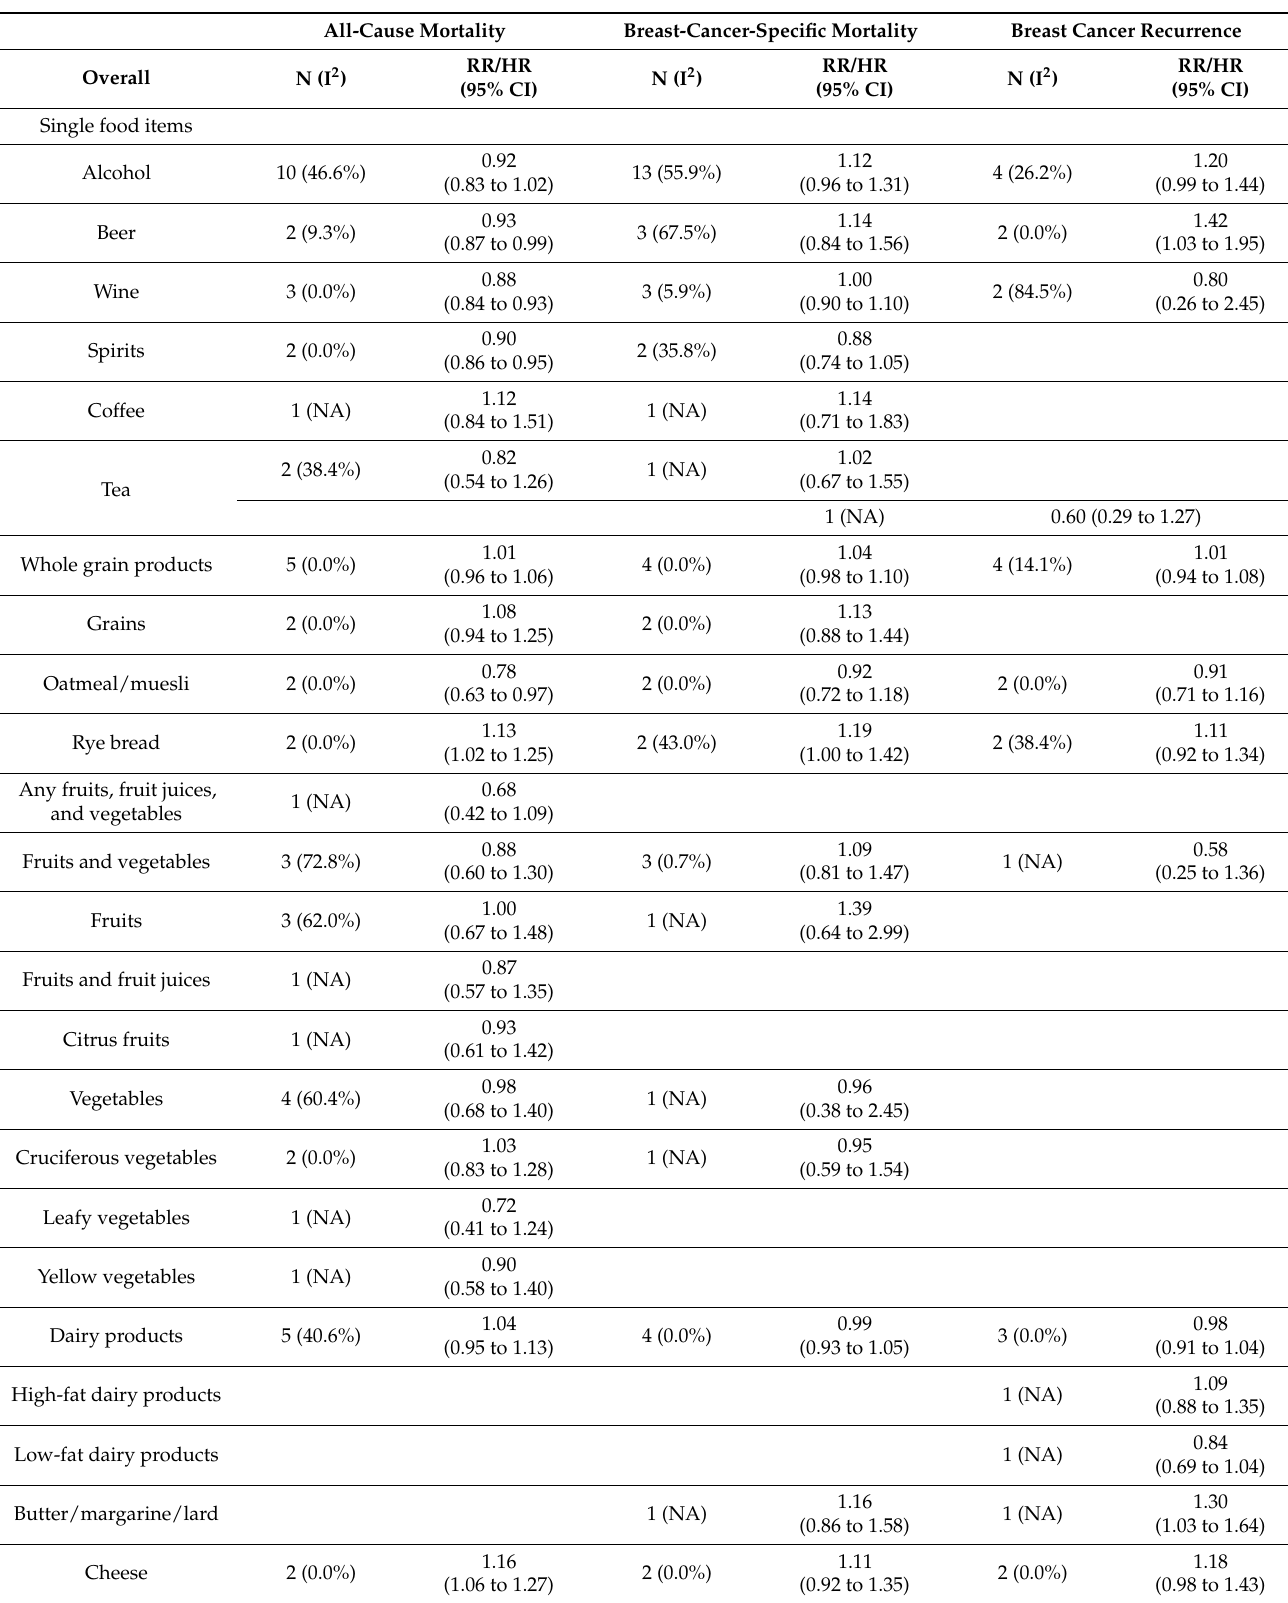
Table 1. Systematic review and meta-analysis of associations between diagnostic dietary factors and breast cancer prognosis among breast cancer